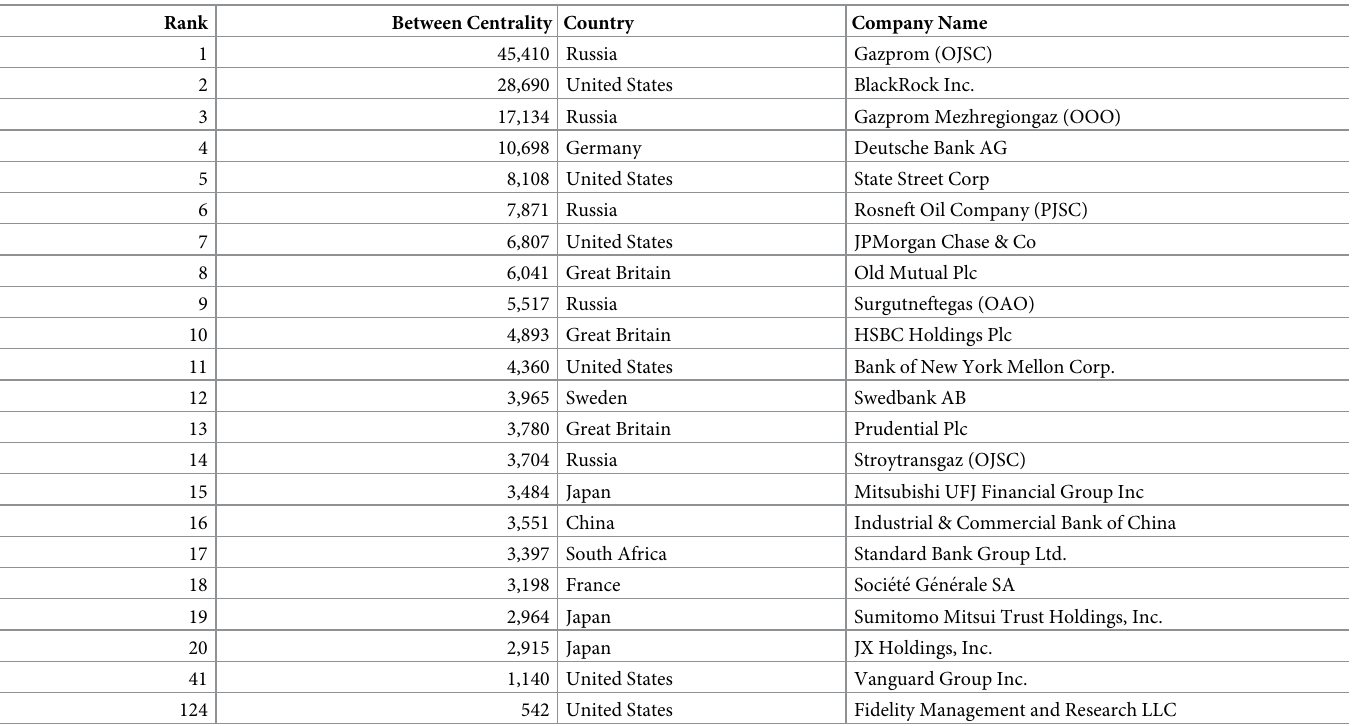
Table 4. Top 20 “bridges” to arms